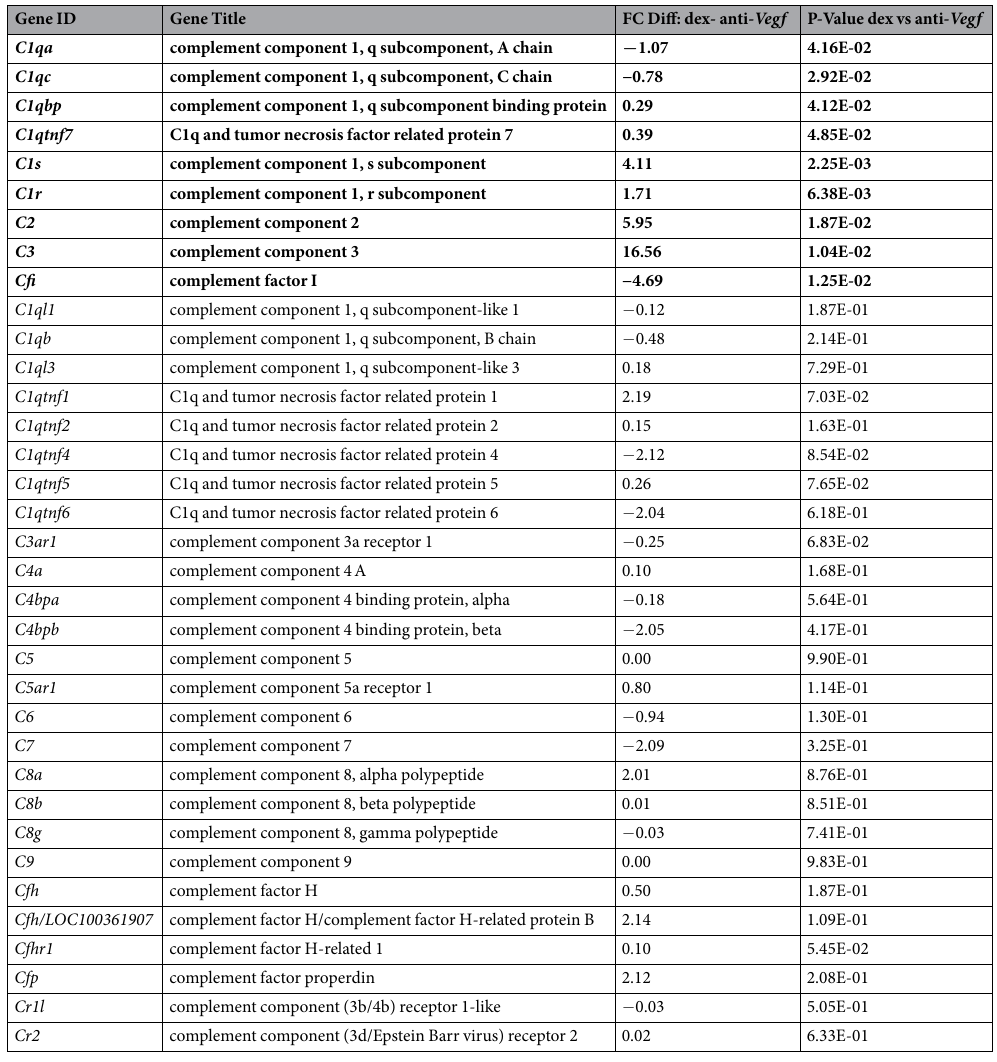
Table 2. Summary of genes involved in the complement cascade from gene microarray analysis, and the FC Diff and the corresponding P values. Highlighted genes are those significantly different between